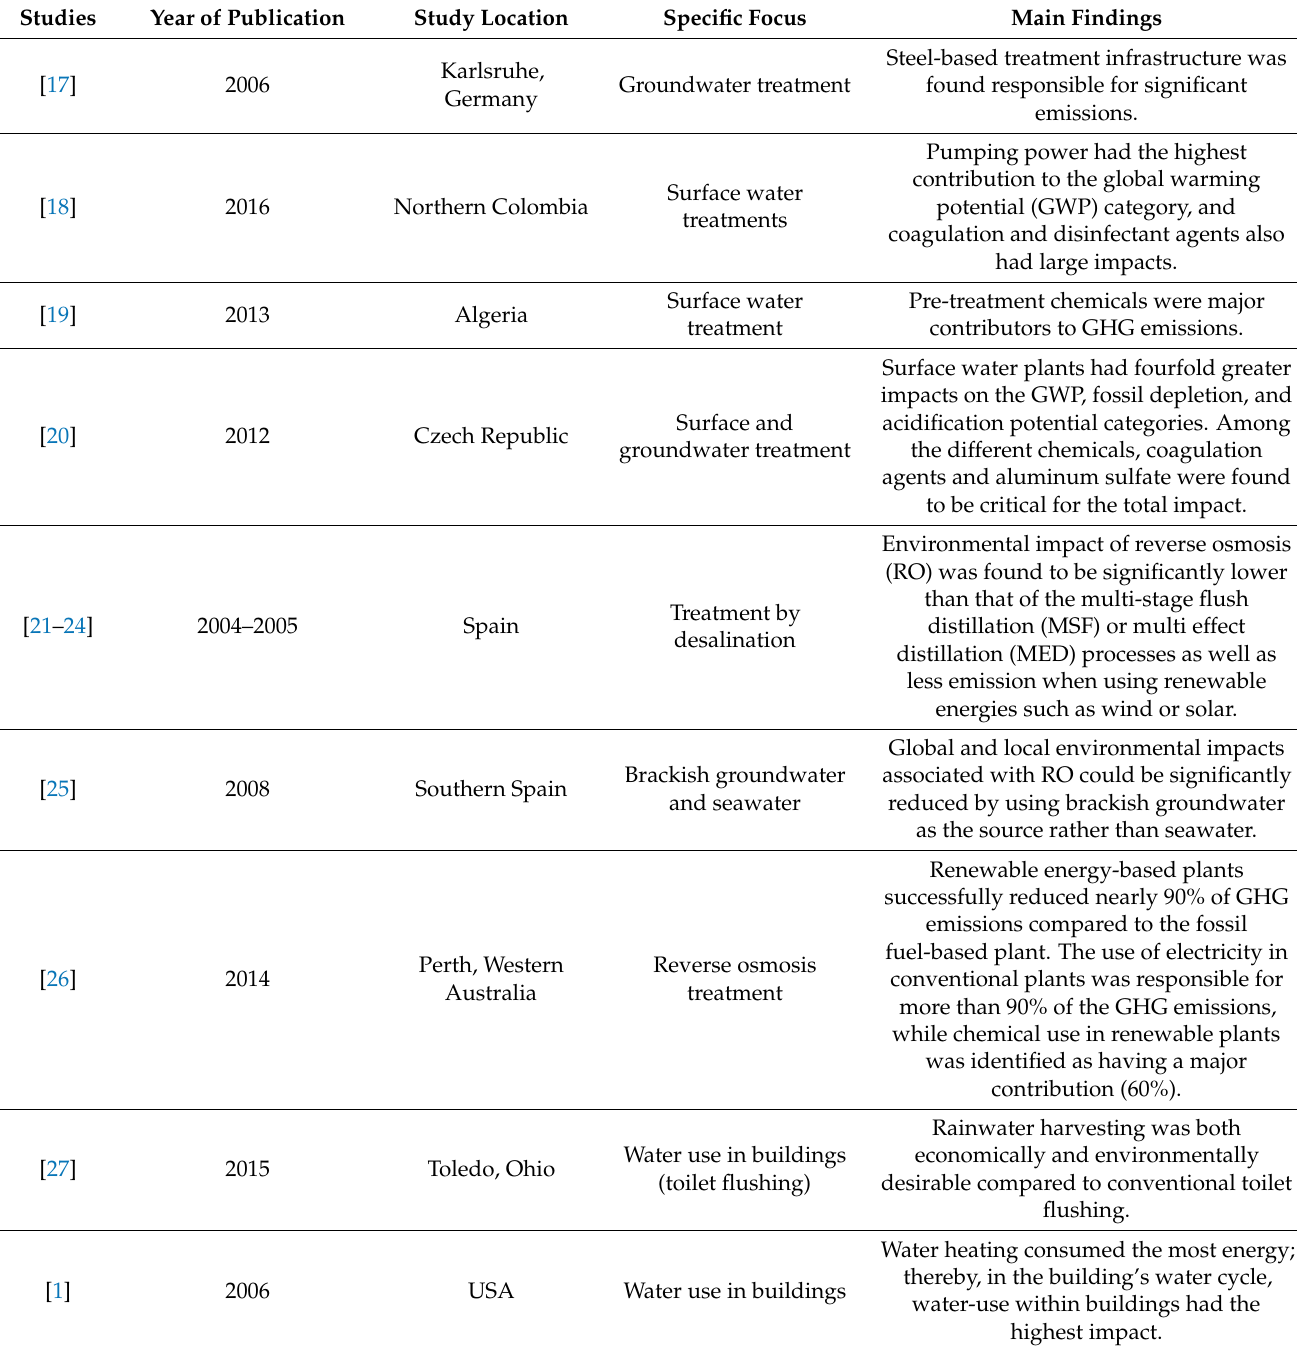
Table 1. List of LCA studies focused on different sector of water cycle for